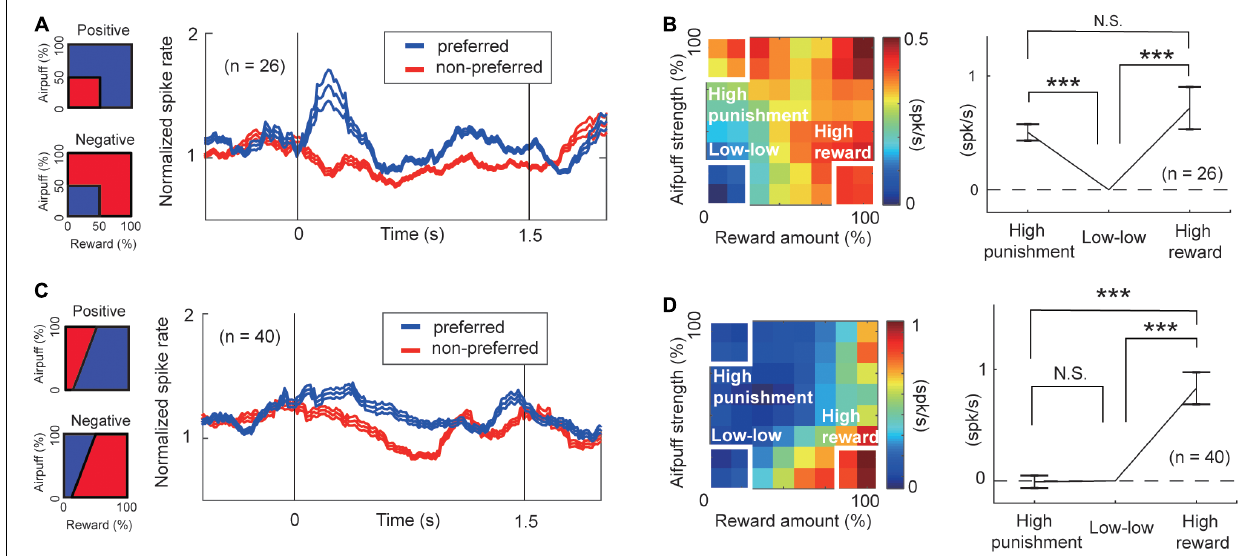
FIGURE 6 | Features of units encoding arousal and valence. (A) Population activity of the arousal-encoding units for the preferred (blue) and non-preferred (red) conditions. The time courses of the activities of the FOE unit were normalized by their precue period activities. Preferred and non-preferred conditions of arousal-positive or FOE( − ) unit (top) and of arousal-negative or FOE( + ) units (bottom) are shown on the left. (B) Mean of the differential activity relative to the “low–low” condition. Activities of FOE( − ) units and the inverse of FOE( + ) activities were mapped on the decision matrix (left). We compared the population mean activity in the “high-punishment,” “low–low,” and “high-reward” conditions (Paired t -test, *** P < 0.001; N.S.: P = 0.29 > 0.05). The arousal-encoding units did not discriminate between high-punishment and high-reward conditions. (C) Population activity of valence-encoding units. Preferred (blue) and non-preferred (red) conditions of the ChV( + ) unit (top) and of ChV( − ) units (bottom) are shown on the left. (D) Mean of the differential activity relative to the “low–low” condition. Activities of ChV( + ) units and the inverse of ChV( − ) activities were mapped on the decision matrix (left). We compared the population mean activity in the “high-punishment,” “low-low,” and “high-reward” conditions (Paired t -test, *** P < 0.001; N.S.: P = 0.87 >